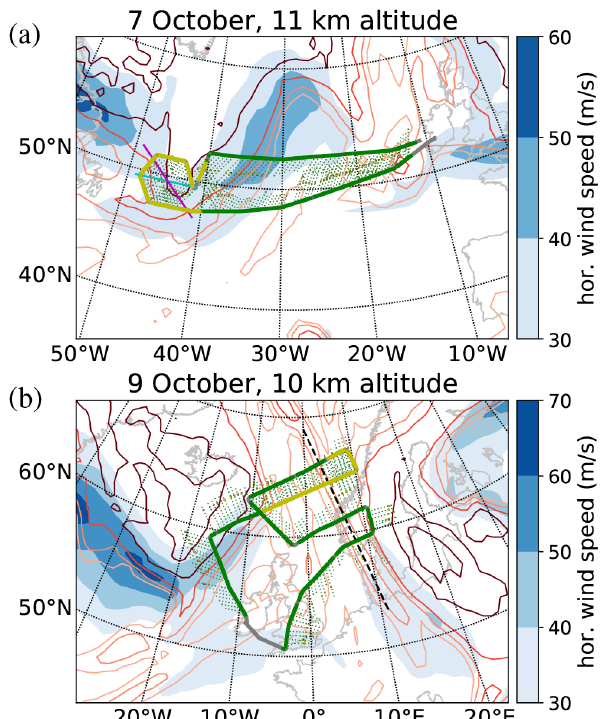
Figure 1. Synoptic situation during measurement flights. Flight track is shown in green for chemistry mode; yellow for dynamics mode measurements. Tangent points are depicted as green dots. Po- tential vorticity contours for 2, 4, 6 and 8PVU, respectively, are shown in increasingly darker reddish colours. Magenta and cyan lines in panel (a) mark the position of cuts shown in Fig. 7; the dashed black line in panel (b) marks a filament with older air from the stratosphere (see Sect. 2.2 for